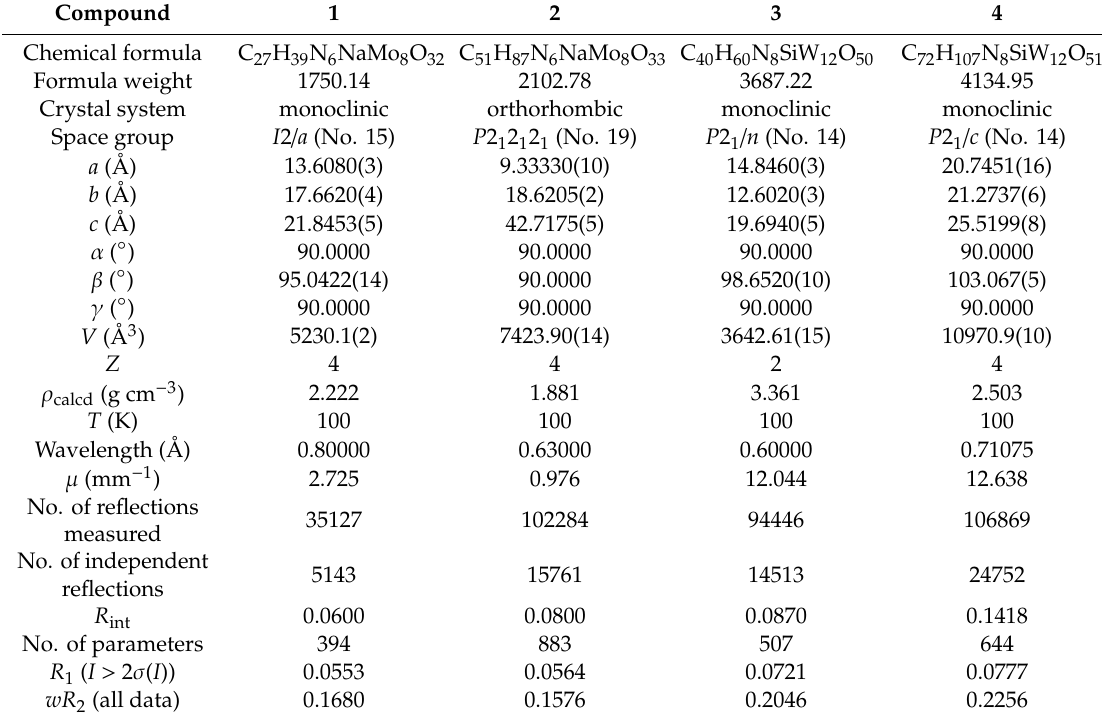
Table 1. Crystallographic data of the hybrid